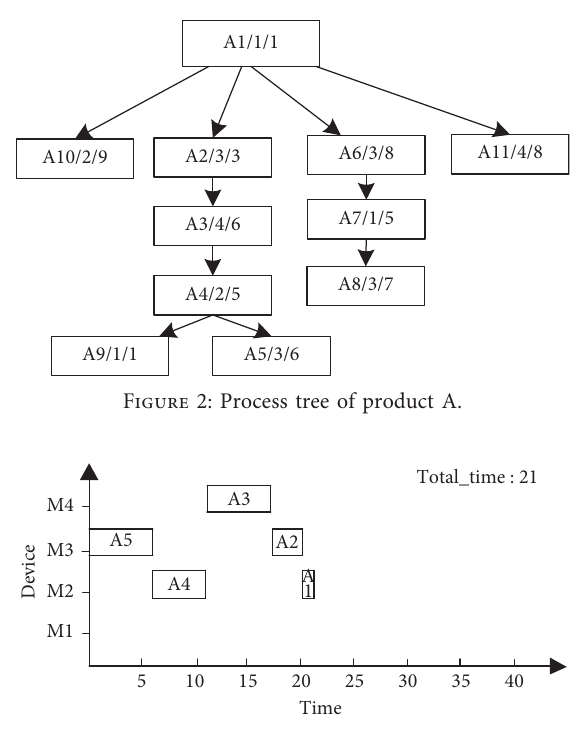
Figure 3: Gantt chart of initial scheduling scheme for product